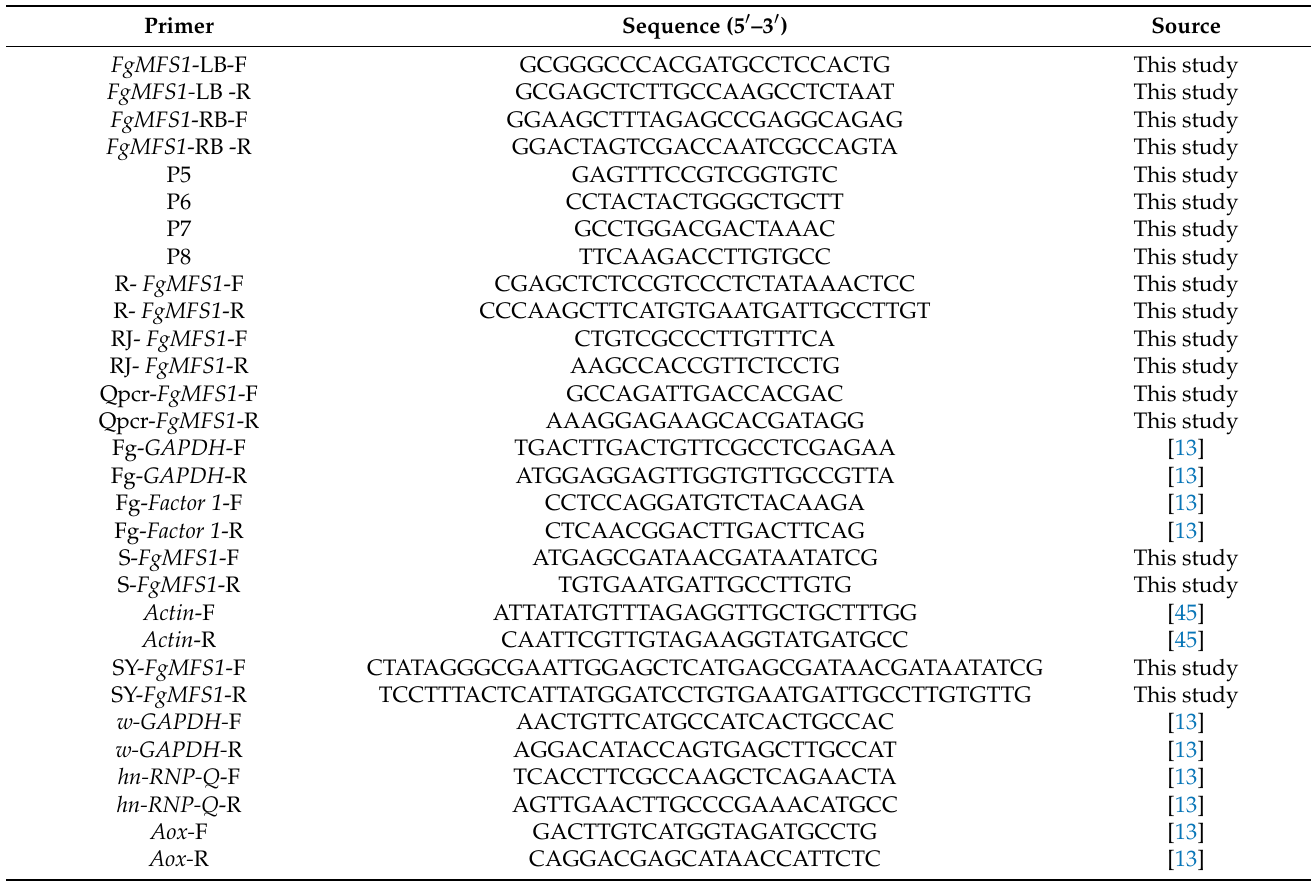
Table 1. Primers used in this